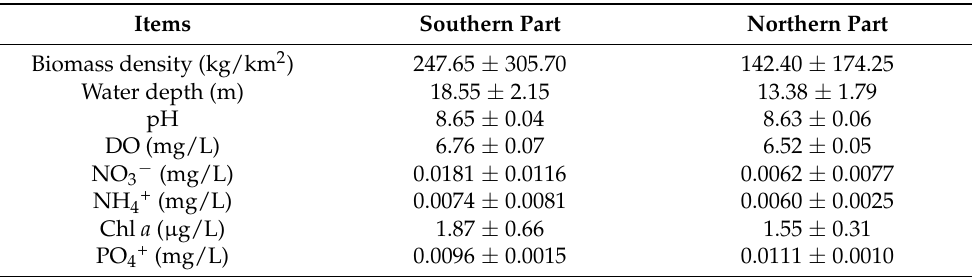
Table A2. Mean values of fish biomass density and environmental factors of the southern part and northern part (mean ±